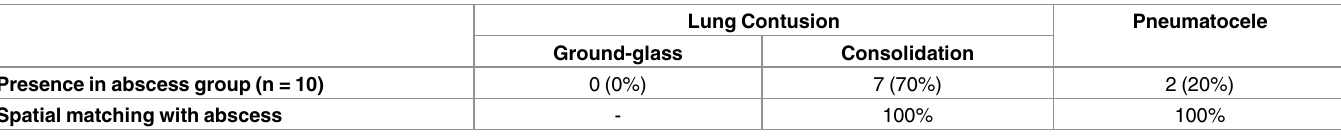
Table 4. Concordance between initial spatial lung injury and abscesses